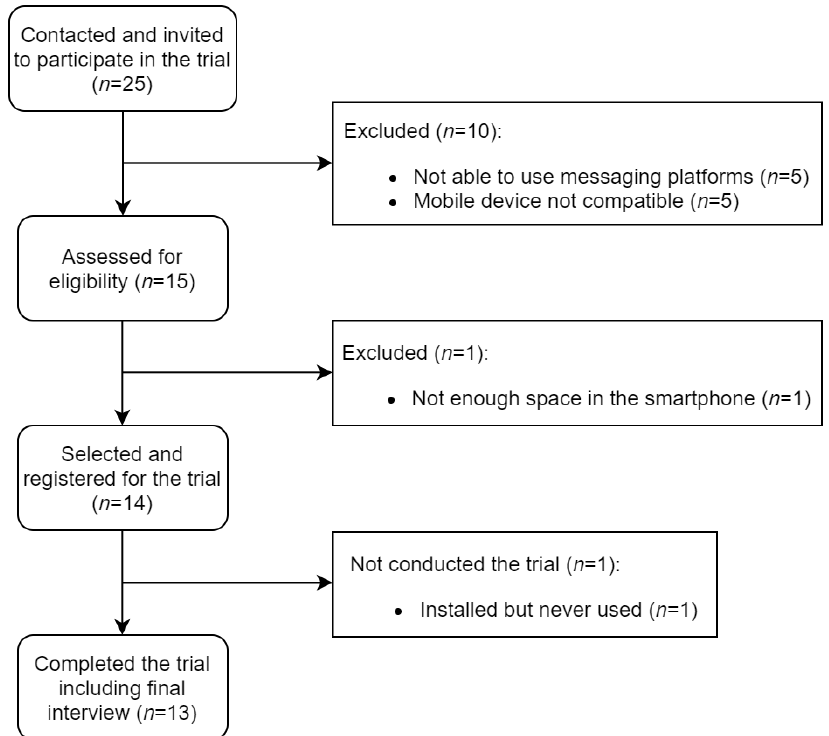
Figure 2. Flow diagram of patient selection and completion of the pilot